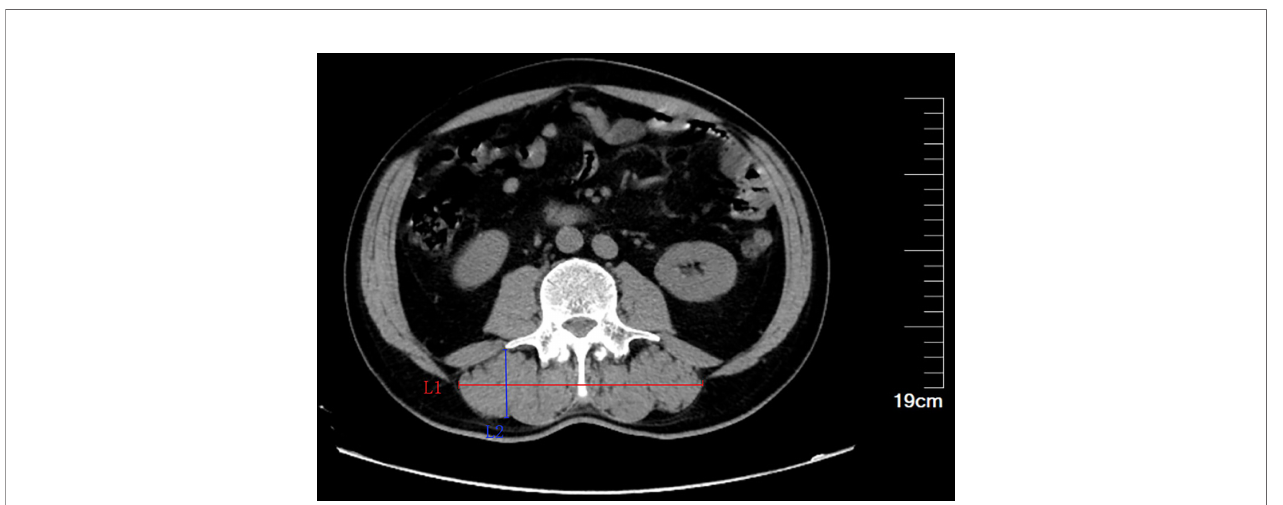
FIGURE 1 | Diagram of transverse and longitudinal diameter of the third lumbar paravertebral muscle group. Ll, maximum diameter in horizontal direction; L2, maximum diameter in vertical